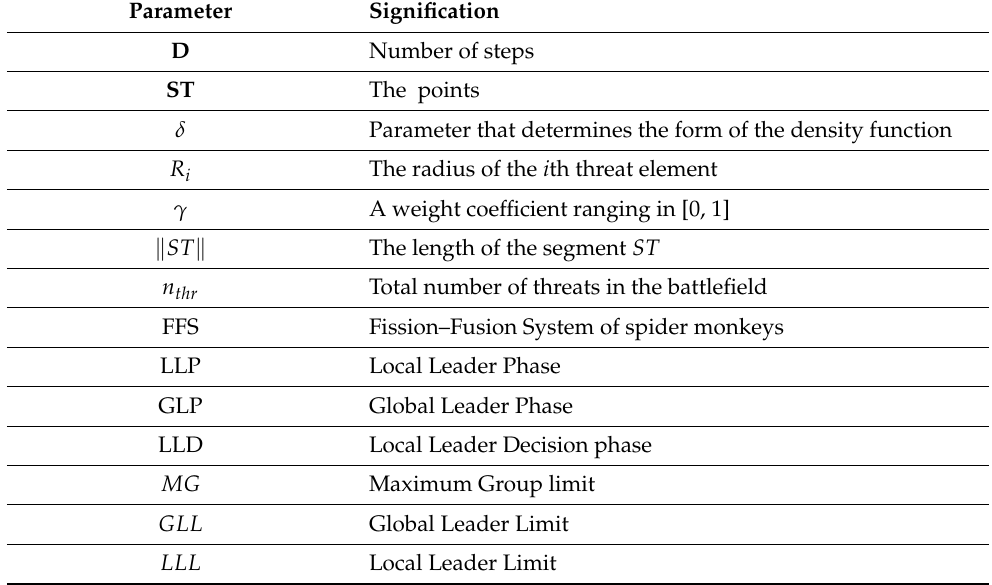
Table A1. Variables, abbreviations, and adjustable control variables